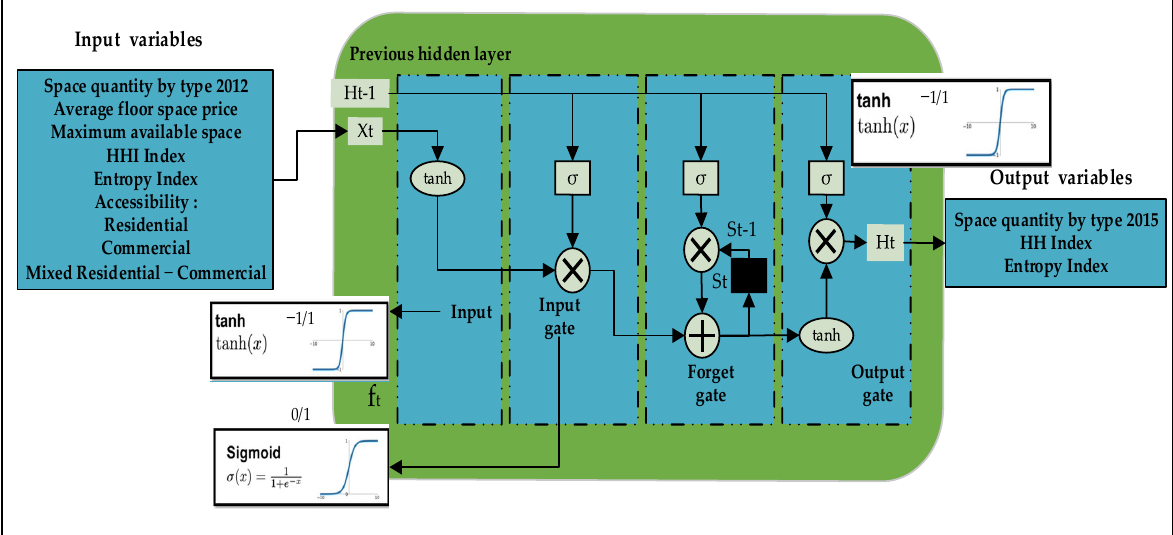
Figure 8. LSTM cell neural network structure.